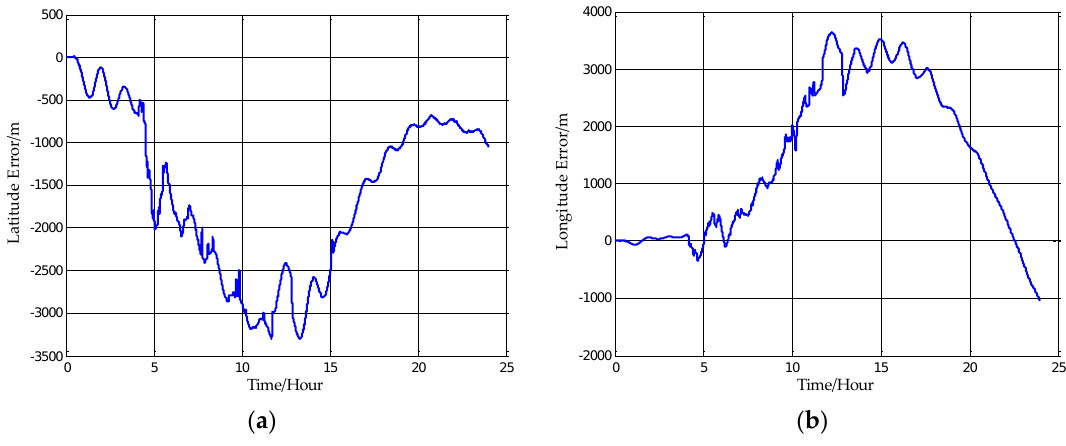
Figure 15. ( a ) is the latitude error without compensation and ( b ) is the longitude error without compensation.